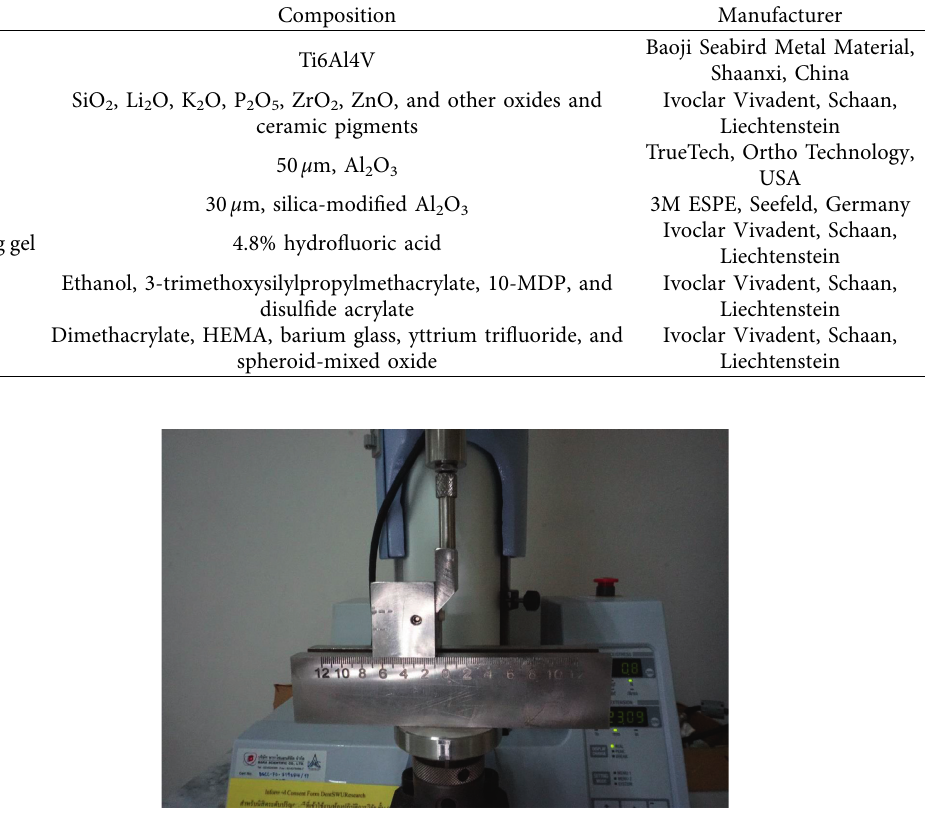
Figure 3: SBS test with a universal testing machine.